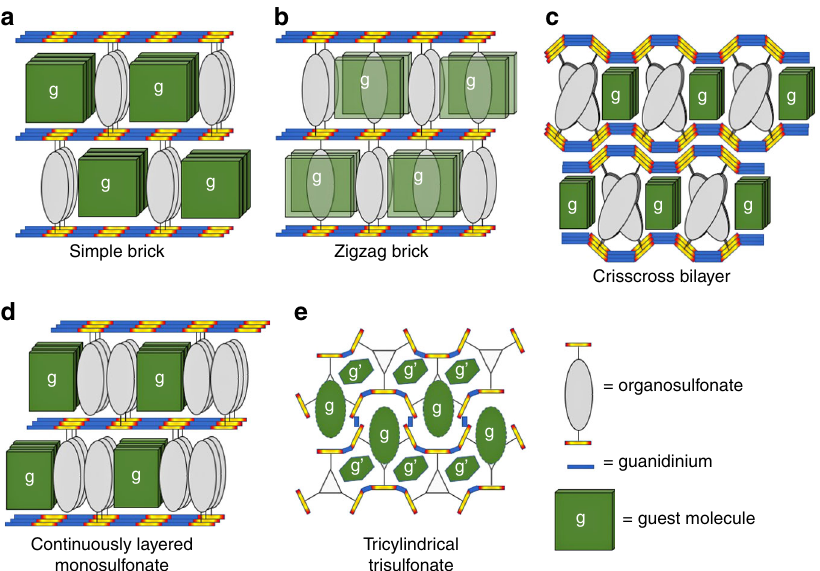
Fig. 2 Schematic representations of host frameworks appearing herein. a – c Guanidinium disulfonate simply brick, zigzag brick, and crisscross bilayer architectures. d Guanidinium monosulfonate continuously layered architecture. e Tricylindrical architecture observed for the guanidinium tri(4- sulfophenyl)benzene host (G 3